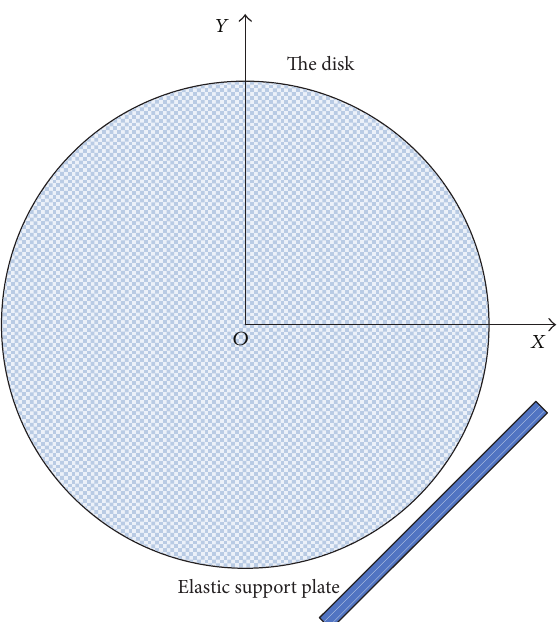
Figure 3: The schematic diagram of rub-impact between rotor disk and